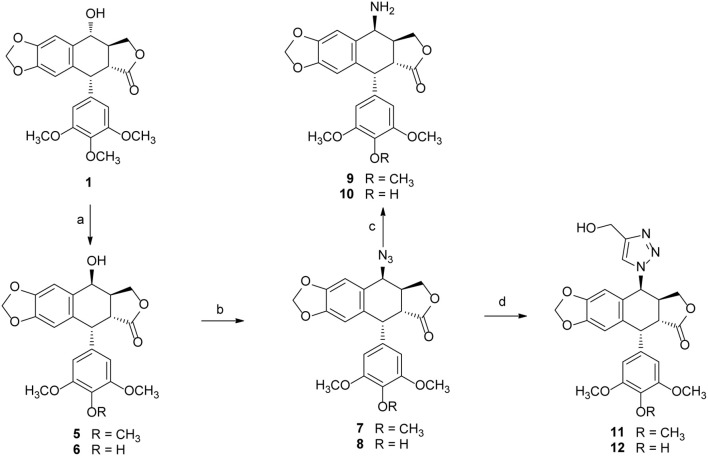
The synthesis of podophyllotoxin derivatives (5–12). Reagents and reaction condition: (a) MeSO3H, NaI, CH3CN/CH2Cl2; then, H2O-Acetone, BaCO3, rt. 90–92%; (b) NaN3-TFA, CHCl3, 67–70%; (c) PPh3, THF, then H2O, 72–75%; (d) copper (II) acetate, propargyl alcohol, sodium ascorbate, t-BuOH-H2O, THF, rt. 85–89%.